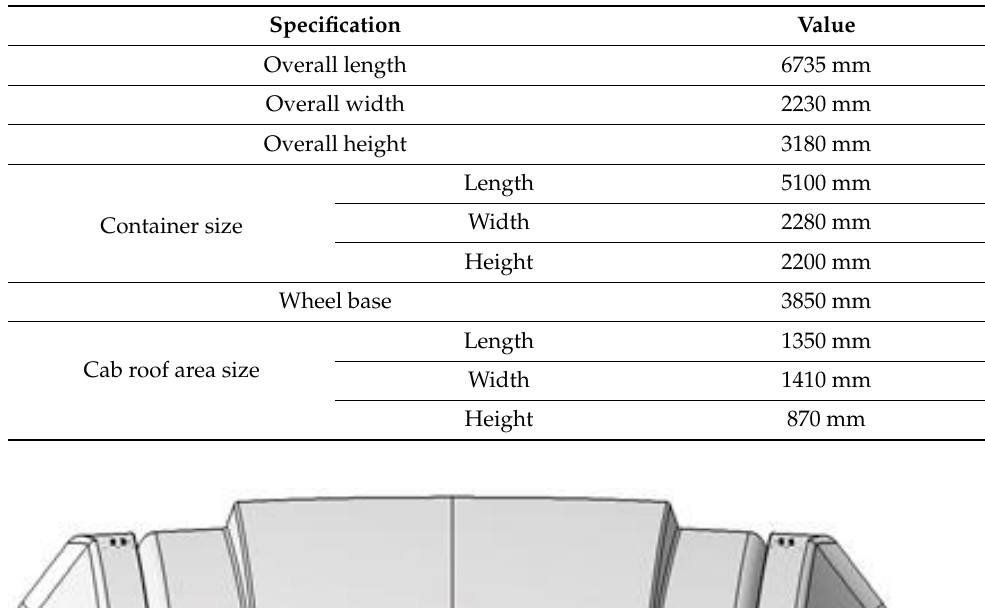
Table 1. Specification of target vehicle. Table 1. Speci fi cation of target vehicle.